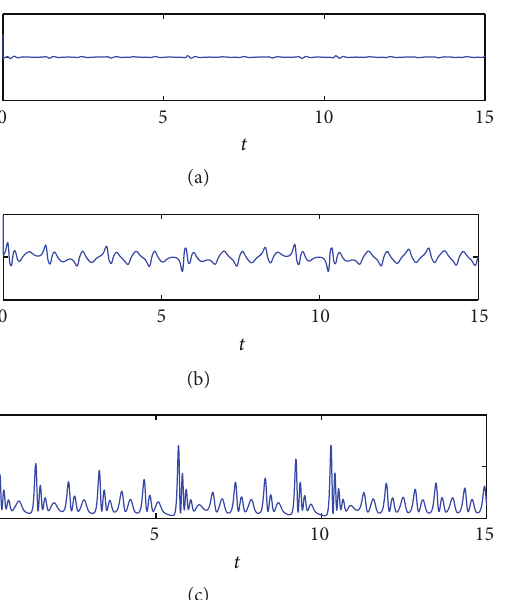
Figure 16: The trajectories of the adaptive laws of the parameter in Example 2.